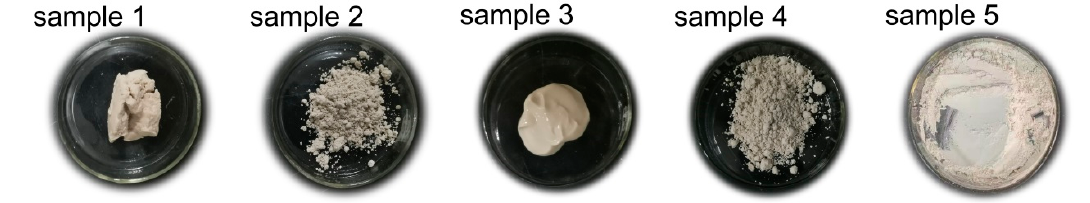
Figure 4. Montmorillonite samples for crystal characterization experiments as Table 2.